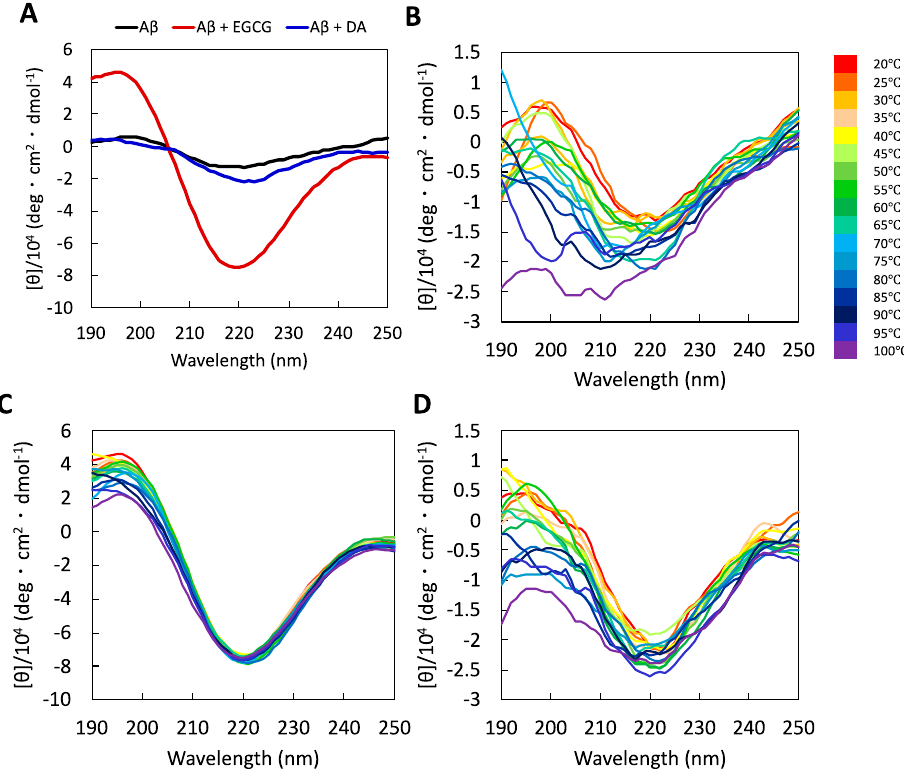
Figure 4. ( A ) Circular dichroism (CD) spectra of A β fibrils (black line). Amyloid β (A β ) samples incubated with epigallocatechin gallate (EGCG; red line) or dopamine (DA; blue line) for 6 h were recorded at 25 °C. A β fibrils were mixed with EGCG or DA at a molar ratio of 1:0.56. Temperature- dependent CD spectra from 20–100 °C of A β fibrils alone ( B ) and in the presence of EGCG ( C ) or DA ( D ) were also recorded.